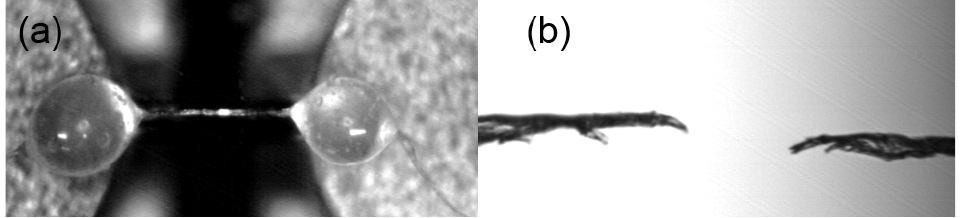
Figure 3. Fiber mechanical properties measurement chart: ( a ) pretension state; ( b ) fracture state of fiber.